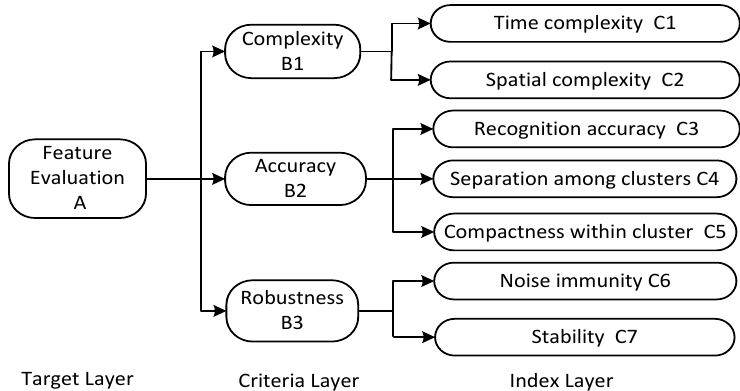
Figure 1. A model of the feature evaluation system.